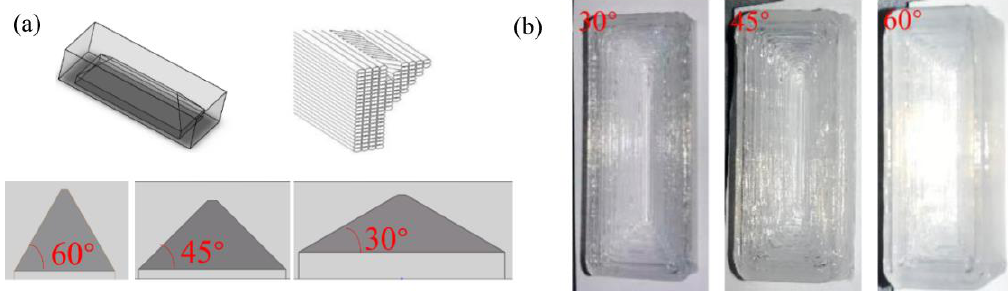
Figure 9. ( a ) Bridging concept and transition inclination angle; ( b ) Photos of the bridge.